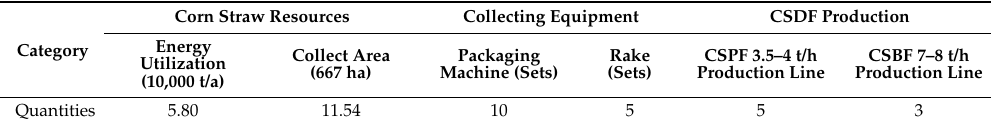
Table 6. Technical process from corn straw resources to CSDF production.